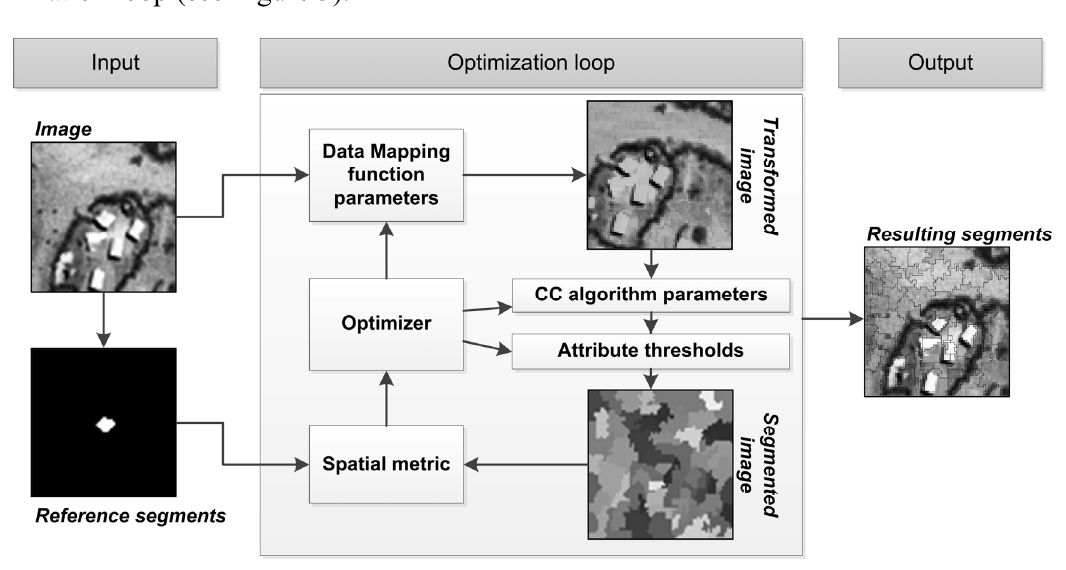
Figure 3. The architecture of the sample supervised segment generation method incorporating data mapping functions and attribute thresholding [3]. IEEE © 2013. Reprinted, with permission, from